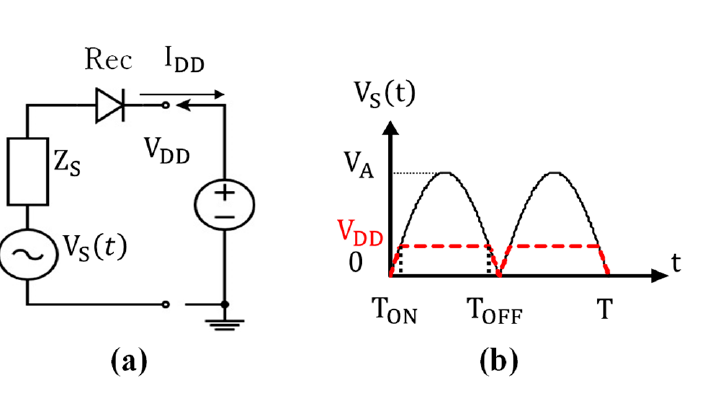
Figure 3. Circuit model for estimating the power conversion efficiency. ( a ) Circuit model; ( b ) volt- age waveform.